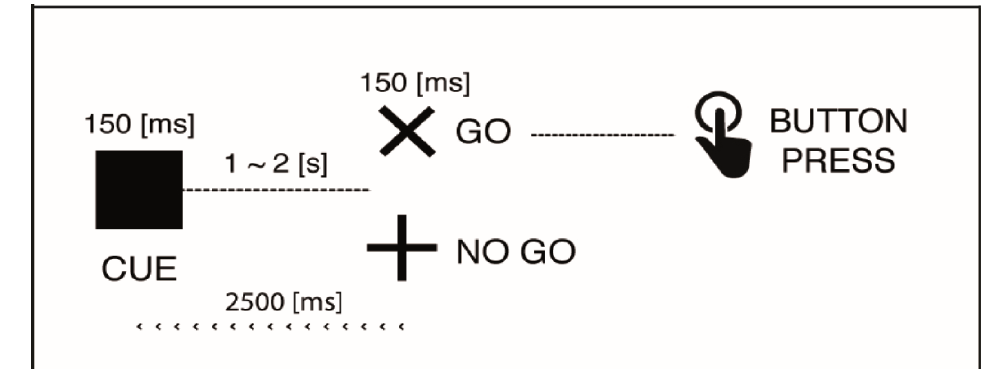
Figure 1. Go/Nogo paradigm.